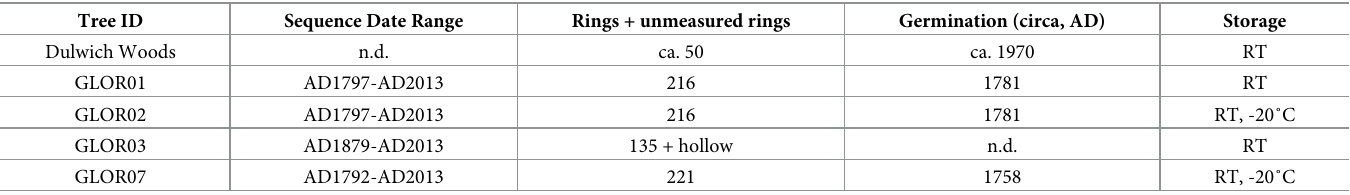
Table 2. The dendrochronological analysis performed on the oak samples. Tree